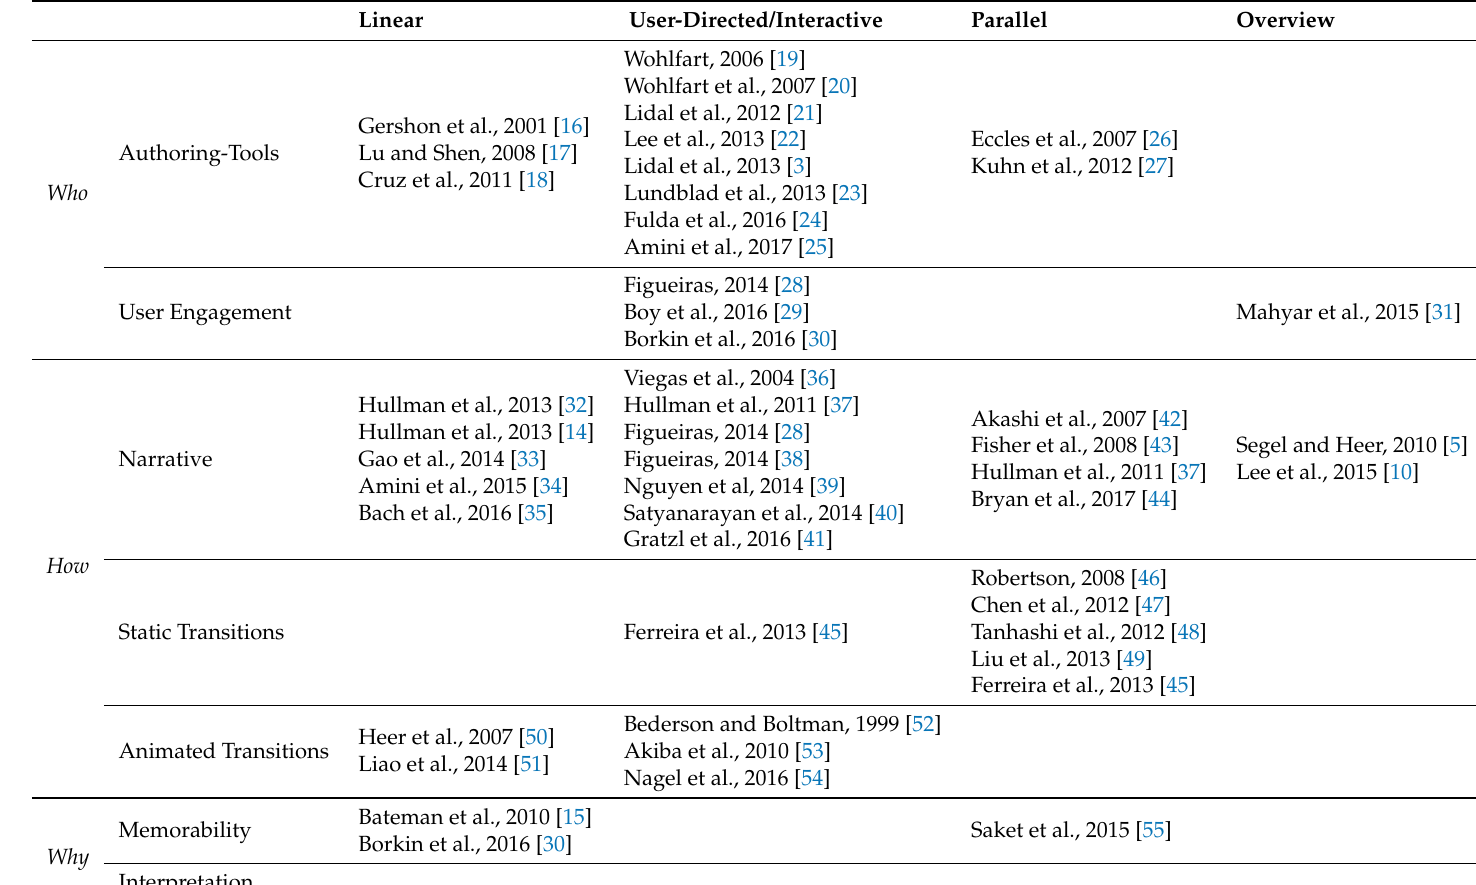
Table 1. Our classification of the storytelling literature. The y -axis categories fall into who-authoring-tools and user-engagement, how-narrative and transitions, why-memorability and interpretation. See Section 1.2 for a complete